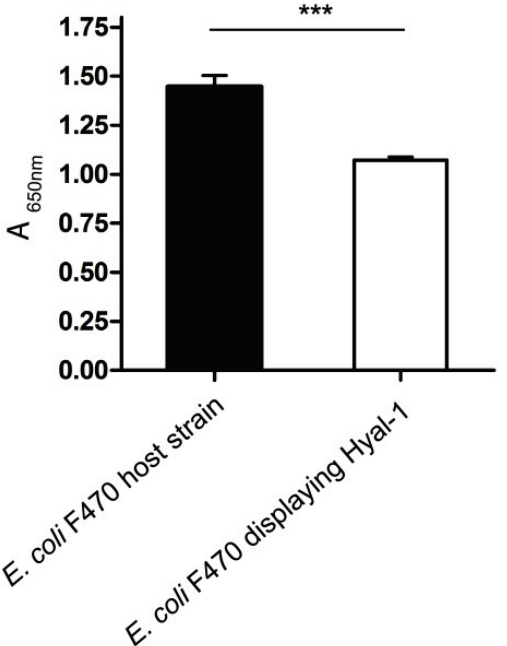
Figure 4. Activity determination of Hyal-1 displayed on the cell surface of E. coli F470. E. coli F470 displaying Hyal-1 and the control sample E. coli F470 not displaying Hyal-1 (host strain) were suspended in formate buffer (pH 3.5), and mixed with the substrate solution resulting in a final OD 578 of 10 and HA final concentration of 0.11 mg/mL. After an incubation time of 5 min the cells were removed by a centrifugation step at 4 °C. 25 µL of the supernatant was applied to the wells of a 96-microplate and mixed with “stains-all” solution following deionized water. A decrease in absorbance indicates activity. The absorbance was measured directly at 650 nm. Data are shown as mean values. ( n = 3, error bars ± SD, *** p < 0.05, unpaired t